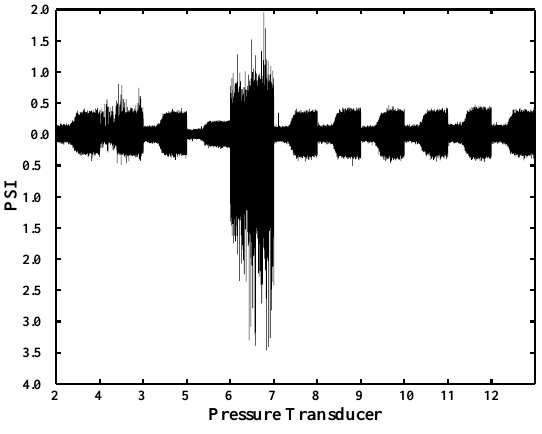
Fig. 13. A comparison of the pressure transducer data sets.